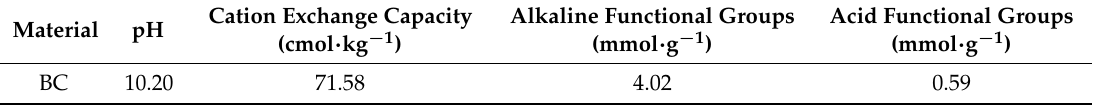
Table 2. The basic properties of